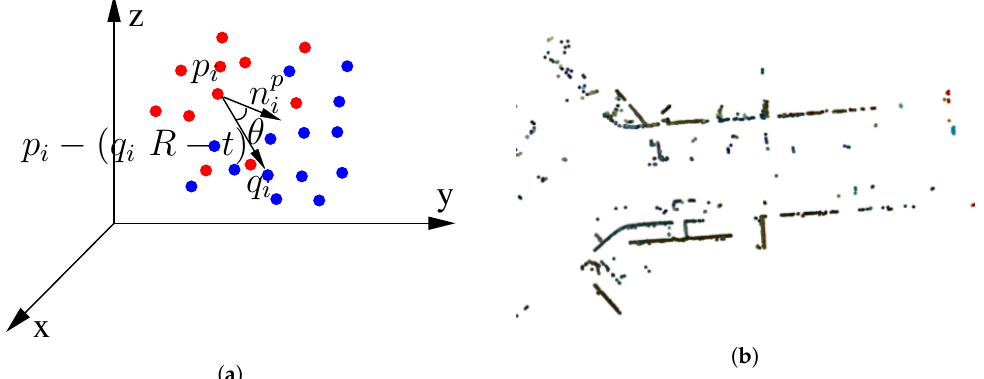
Figure 9. ICP process based on normals: ( a ) Graphical representation of the cost function with the normal unit vector n p used to enter constraints in ICP; and ( b ) ICP output result applying constraints i of normals. The figure shows the overlap of two consecutive